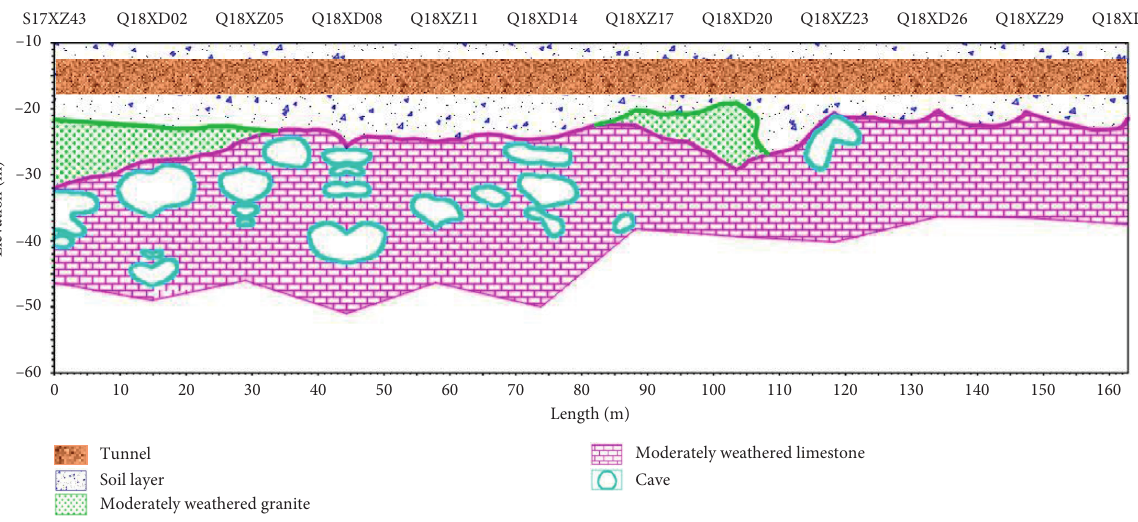
Figure 5: Cross-section view of the karst geology between boreholes